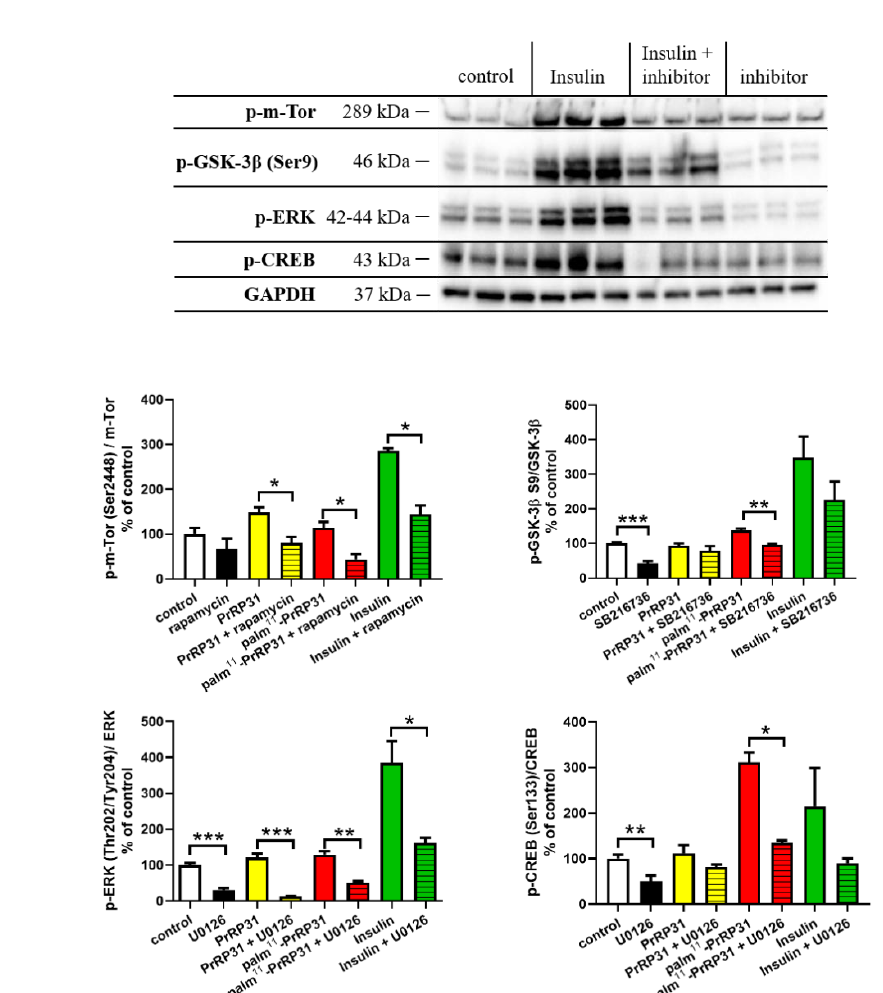
Figure 3. Inhibitors proved that activation of signaling pathways were mediated exclusively via PrRP31 and its palmitoylated analog. Immunoblots with PrRP31 and palm 11 -PrRP31: ( a ) and insulin: ( b ) and their quantifications: ( c ). SH-SY5Y cells were incubated firstly with selective inhibitors for 2 min and then either with PrRP31 and its palmitoylated analog at a final concentration 1 × 10 − 5 M, or with insulin in the final concentration 1 × 10 − 7 M at 37 ◦ C for 8 min, or alone in serum-free medium. Activated protein was normalized to loading control, GAPDH. Data are presented as the means ± SEM as a percentage of control cells treated with medium alone. Analysis is made between groups as shown in the graph by a Student’s t -test, * p < 0.5, ** p < 0.01, *** p < 0.001(each sample in triplicates).